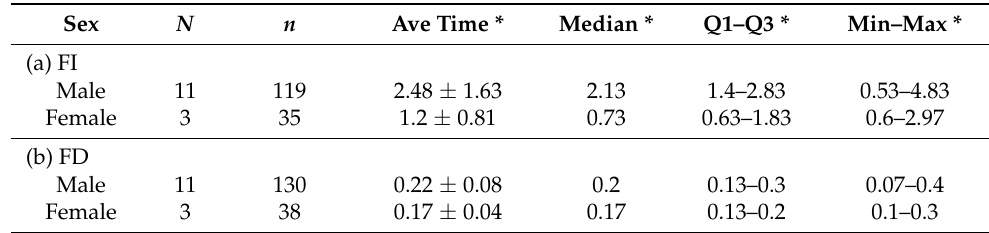
Figure 3. Flash patterns of flying and perching adult males and females of A. cerata . ( A ) Comparative flash timing diagrams. ( B , C ) Comparative boxplots of FI (or FD) patterns while flying and perching in males and females. The FI (or FD) data points (gray spots) in each boxplot were determined by continuous flash signals (lasting 5–25 s) from 3 to 7 distinct individuals. ‘ n ’ represents the total FI or FD. Significance: * p < 0.05, *** p < 0.001. NS: no significance. A.U.: arbitrary units. Table 2. Statistical results of FI and FD from perching A. cerata